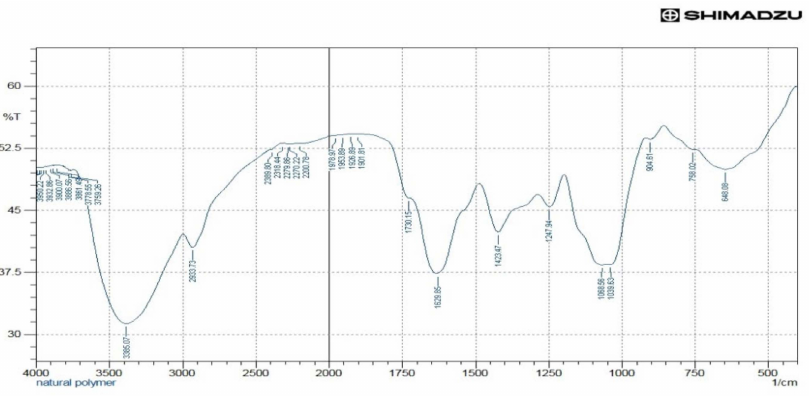
Figure 4. FTIR analysis of the mucilage.